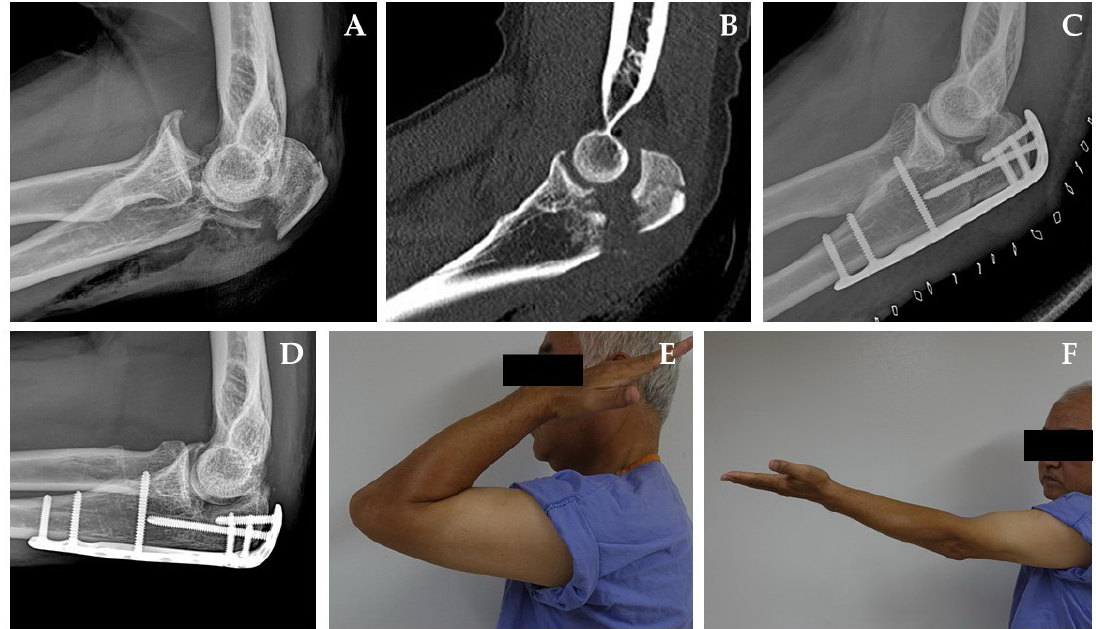
Figure 2. A sixty-year-old man sustained a trans-olecranon fracture-dislocation of the left elbow